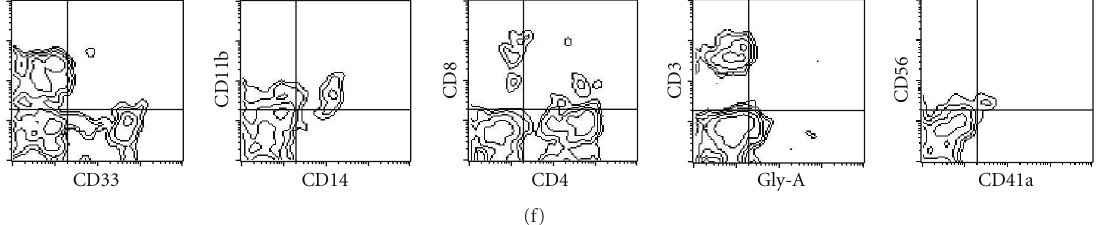
Figure 4: Flow cytometric analysis of hematopoietic cells of the mouse that had been transplanted with human hematopoietic cells produced by in vitro culture. ((a), (e)) Schema of the experimental procedure and flow cytometric analysis of transplanted cells. ((a)– (d)) Detached cells (3 . 9 × 10 6 cells) produced on OP9 feeder cells (Exp-OP9-A) were collected on Day 169 of culture and transplanted into an immunodeficient NOG mouse. Peripheral blood was collected on Days 56 (b) and 112 (c) after transplantation, and bone marrow cells were collected on Day 126 after transplantation (d). ((e), (f)) Detached cells (2 . 4 × 10 6 cells) produced on OP9 feeder cells (Exp- OP9-F) were collected on day 125 of culture and transplanted into an immunodeficient NOG mouse. The bone marrow cells were collected on Day 184 after transplantation and were analyzed. ((a)–(f)) The cells were stained using monoclonal antibodies against CD45, a leukocyte common antigen, CD34, a marker specific for hematopoietic stem/progenitor cells, CD33 and CD13, markers of granulocyte and monocyte/macrophage lineage cells, CD11b and CD14, markers of monocyte/macrophage lineage cells, CD19, a marker of B lymphocyte lineage cells, CD3, CD4, and CD8, markers of T lymphocyte lineage cells, Gly-A (Glycophorin A), a marker of erythroid cells, CD56, a marker of large granular lymphocytes and natural killer cells, and CD41a, a marker of megakaryocyte/platelet lineage